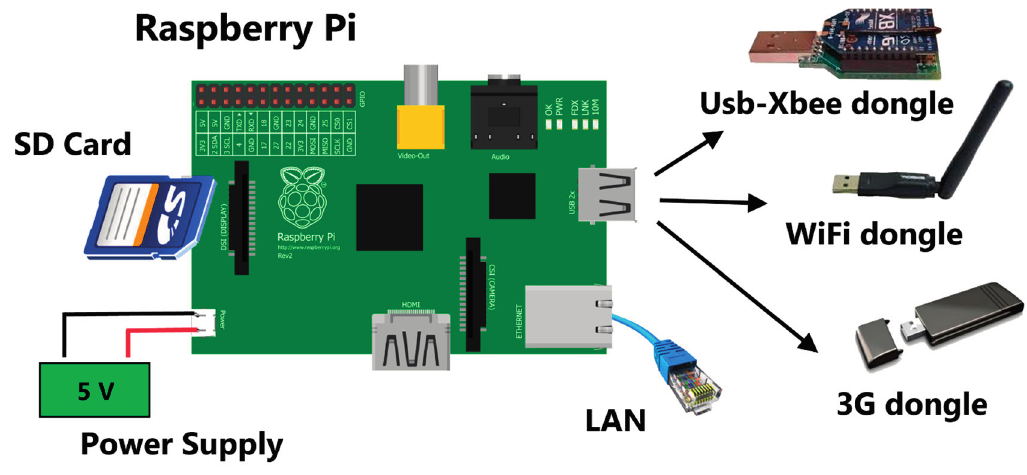
Figure 4. Scheme of coordinator unit